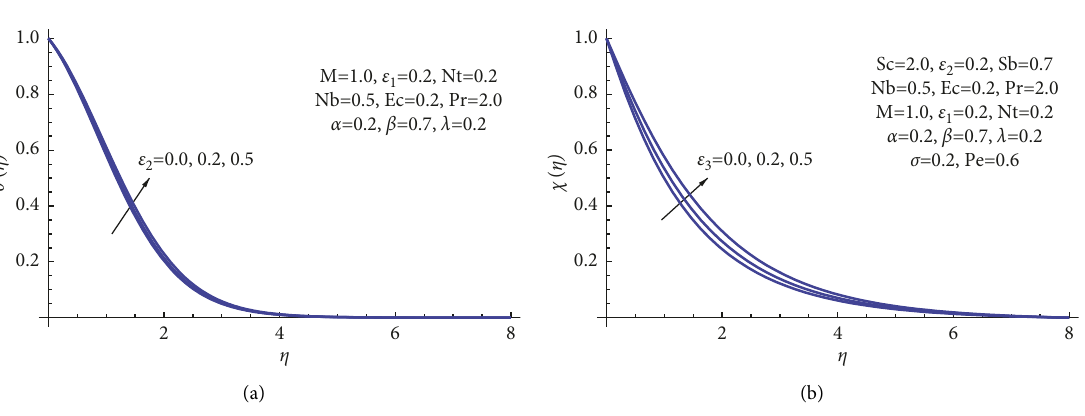
on ϕ ( η ) . (b) Impact of ε 2